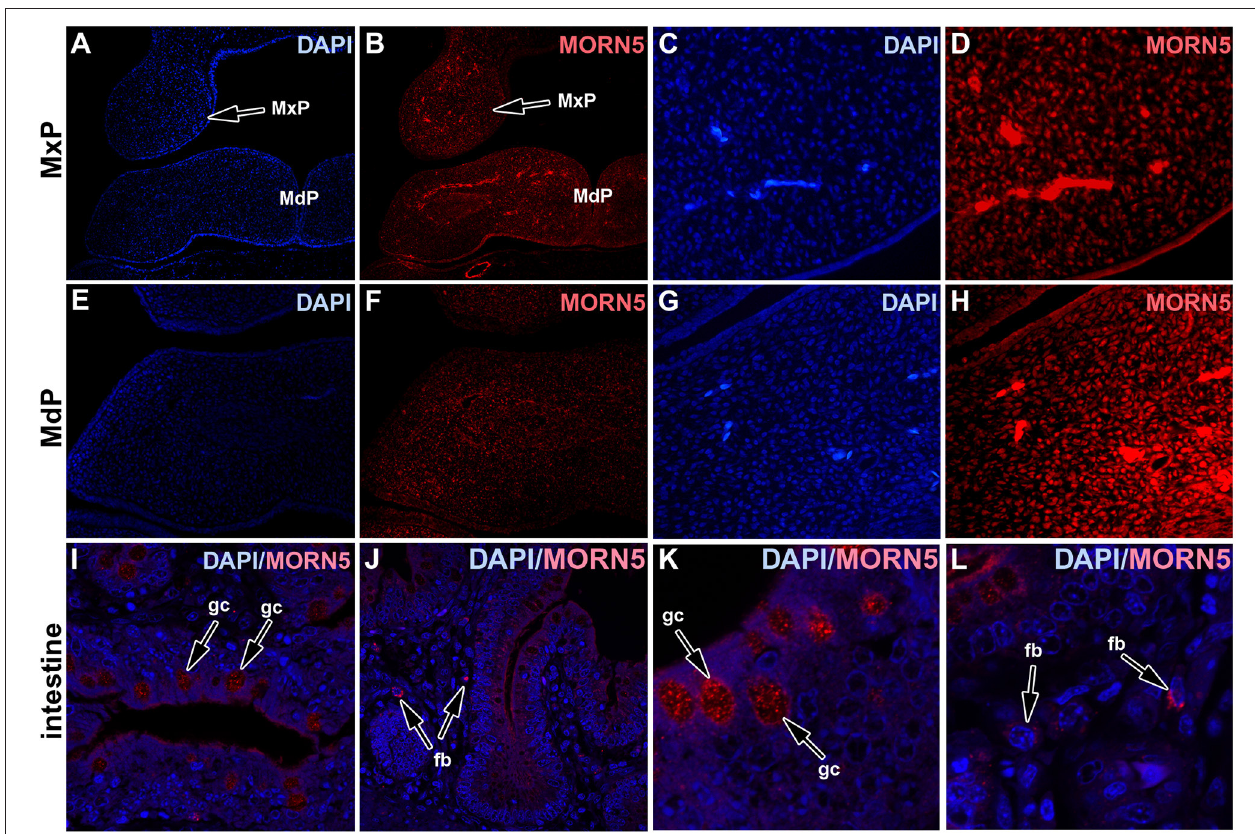
FIGURE 6 | MORN5 protein detected by immunofluorescent labeling. (B,D) MORN5 protein was localized in the maxillary prominences at stage HH24. (F,H) In the mandibular prominence, there is very low signal in the mesenchyme. MORN5 expression showed dispersed pattern of distribution. (A,C,E,G) DAPI staining. (I–L) Chicken intestine was used as a positive control with strong positivity in Goblet cells (gc), in the apical parts of enterocytes and also spotted expression in fibroblasts (fb). MdP, mandibular prominence; MxP, maxillary